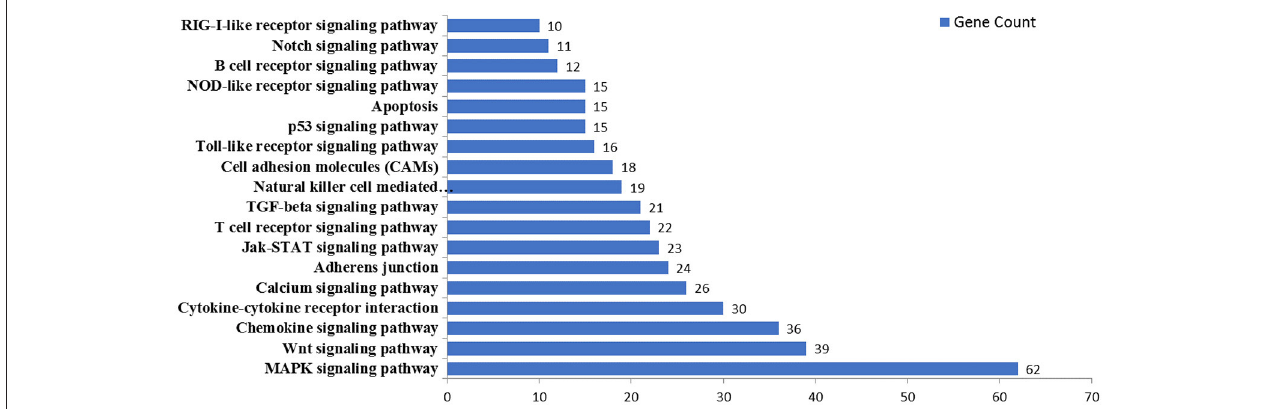
FIGURE 5 | KEGG pathway analysis of predicted targets of differentially expressed miRNAs. The potential targets of four selected miRNAs were predicted by using TargetScan and MicroCosm. These predicted targets were further analyzed by using DAVID version 6.7. The number of predicted targets in 18 pathways associated with IAV replication were